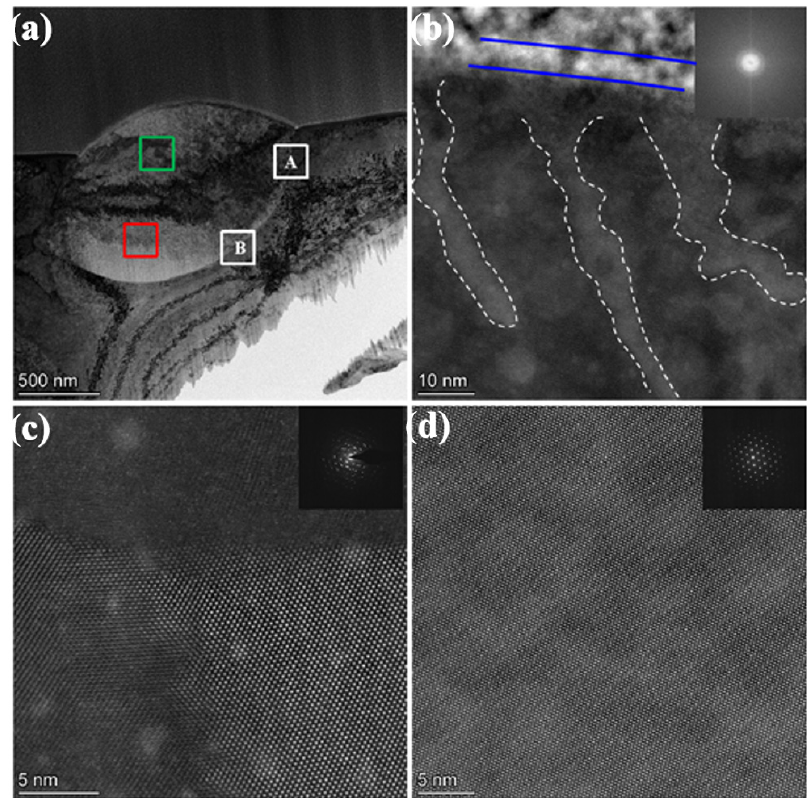
Figure 3. The typical morphology of ZrO 2 precipitate in the swaged W-1.5ZrO 2 composites after 1.5 × 10 15 Au + /cm 2 radiation: ( a ) low magnification TEM images, ( b ) STEM-HAADF atomic lattice image on the ZrO 2 precipitate surface and corresponding FFT diffraction patterns, ( c ) STEM-HAADF image of polycrystallization regions and corresponding SAED patterns, ( d ) STEM-HAADF image of unirradiated regions and corresponding SAED patterns. A and B in the white box represents irradiated and unirradiated region, respectively. b) and unirradiated (c and d) phase boundary regions between the ZrO 2 phase and the W matrix. The irradiated (100 nm depth) and unirradiated region (500 nm depth) are labeled as A and B in Figure 3a. As seen in the three elemental mapping, the ZrO 2 phase and W matrix are located on the left and right of Figure 4a,c (the line profile direction is marked by red arrows). Simultaneously, it can be discovered that the phase boundary width of irradiated region is larger than the unirradiated region. These two region line profiles also demonstrate that the transition layer of different element components at the phase interface between the second phase ZrO 2 and the W matrix increases from 2 nm to 8 nm. This suggests high dpa heavy ion irradiation aggravated the diffusion behavior of elements on the phase boundary. High-energy particle bombardment will give element solutes much greater migration energy in the ZrO 2 precipitate and the W matrix. These high-energy alloying elements will escape from damage regions to low energy precipitate interfaces, even diffusion into other grain beyond the precipitate boundary. Hereafter, with the increase in irradiation damage, more element solutes in the W matrix and the ZrO 2 precipitate diffuse each other and form an element transition layer with a certain width at the precipitate interfaces